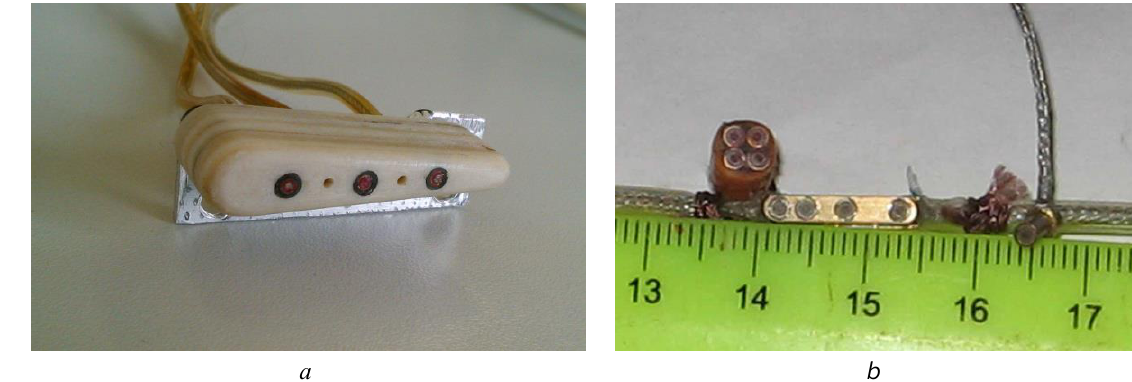
а b Figure 3. Sensor’s block (a) and miniature pressure fluctuation sensors